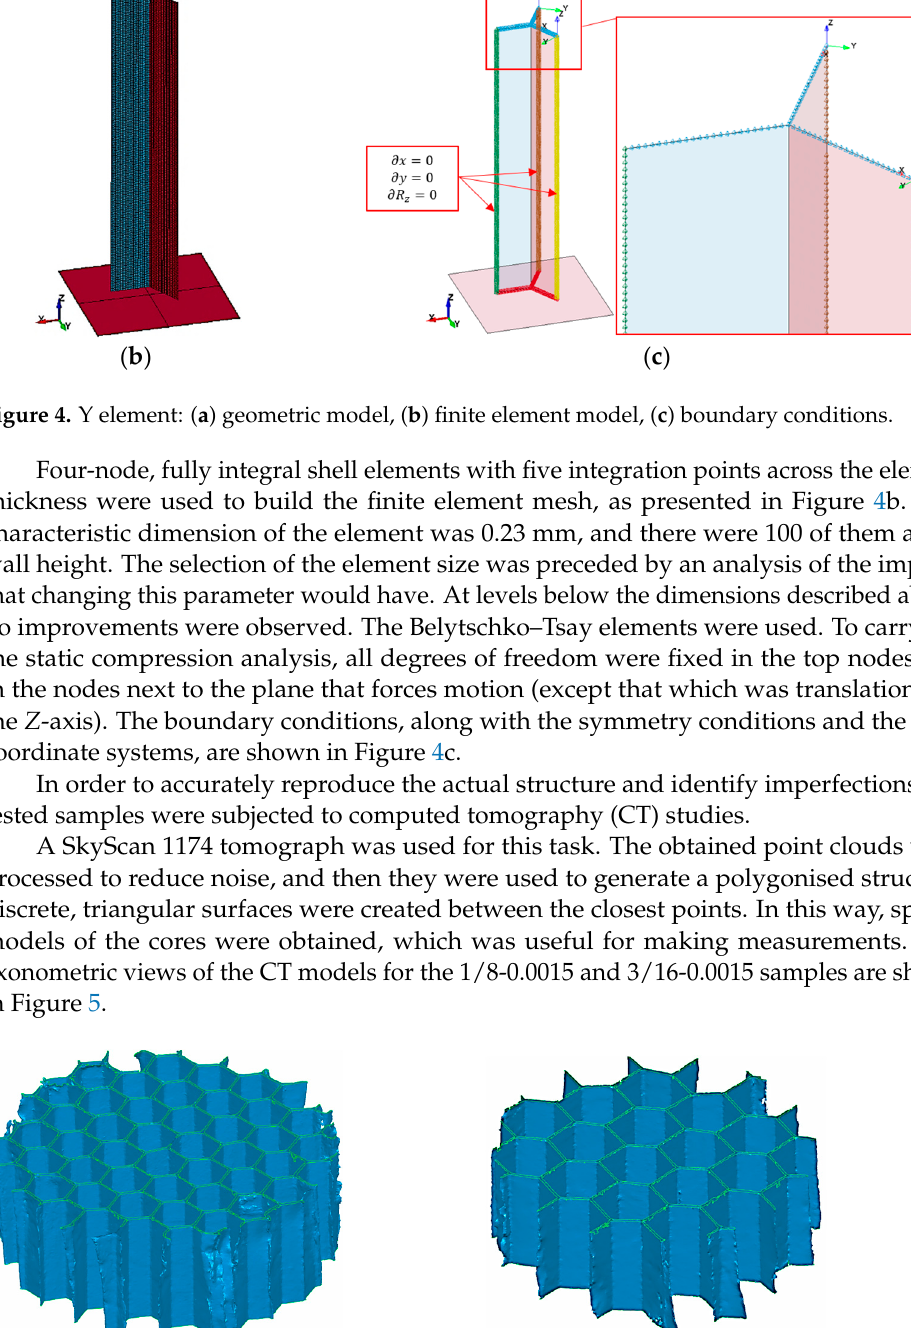
5 of 20 Figure 3. A single cell (Y element), as contained within a honeycomb structure. As indicated in [13–15], structures consisting of repeating elements can be analyzed by solely focusing on a model that has been simplified down to the level of a segment, using appropriate boundary conditions. In the case of the analyzed structures, these con- ditions were limited to the treatment of the sides of the subarea as planes of symmetry. The geometric model shown in Figure 4a, when prepared for discretization, consisted of three walls connected to each other in line with one of the longer edges. The walls were connected to each other at an opening angle of 120°. Four-node, fully integral shell elements with five integration points across the ele- ment thickness were used to build the finite element mesh, as presented in Figure 4b. The characteristic dimension of the element was 0.23 mm, and there were 100 of them at the wall height. The selection of the element size was preceded by an analysis of the impacts